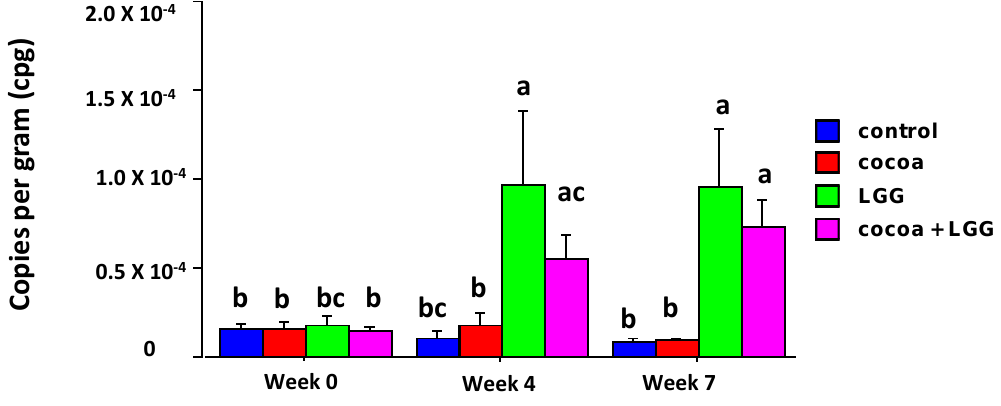
Figure 2. Bacterial LGG abundance in feces of pigs fed different diets. Lactobacillus rhamnosus abundance was measured by real time PCR and converted to copy number per gram of feces (cpg). Values shown are means ± SEM ( n = 8 per treatment). Different letters denote differences among treatments after ANOVA ( p <